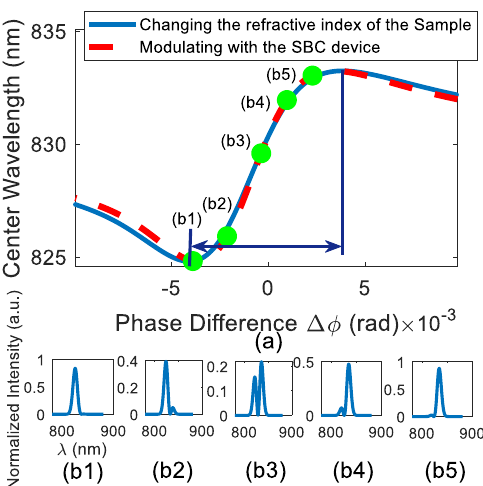
Figure 2. ( a ) The phase difference in the system affects the center wavelength of the system (the blue line in the figure is the phase difference in the system that changes by adjusting the SBC, and the red line in the figure changes the phase difference in the system by changing the refractive index of the total internal reflection surface of the prism). ( b ) b1 – b5 are the spectra corresponding to the marked points in Figure 2a.